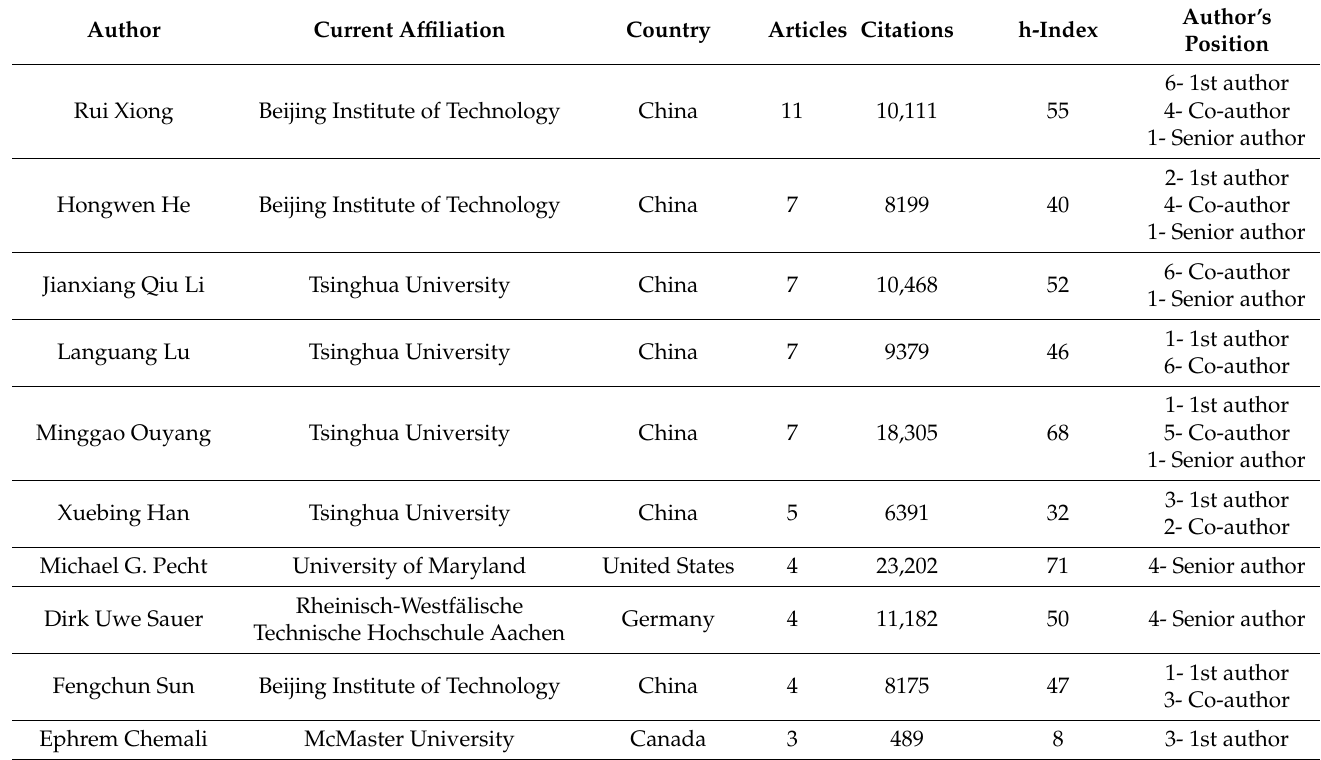
Table 3. Ten most prolific authors’ profiles with 3 or more